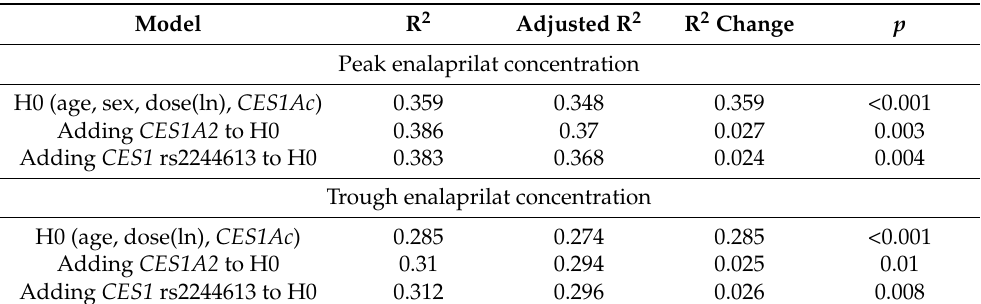
Table 5. Comparison of linear regression models for peak and trough enalaprilat concentrations, using CES1A2 or rs2244613 as